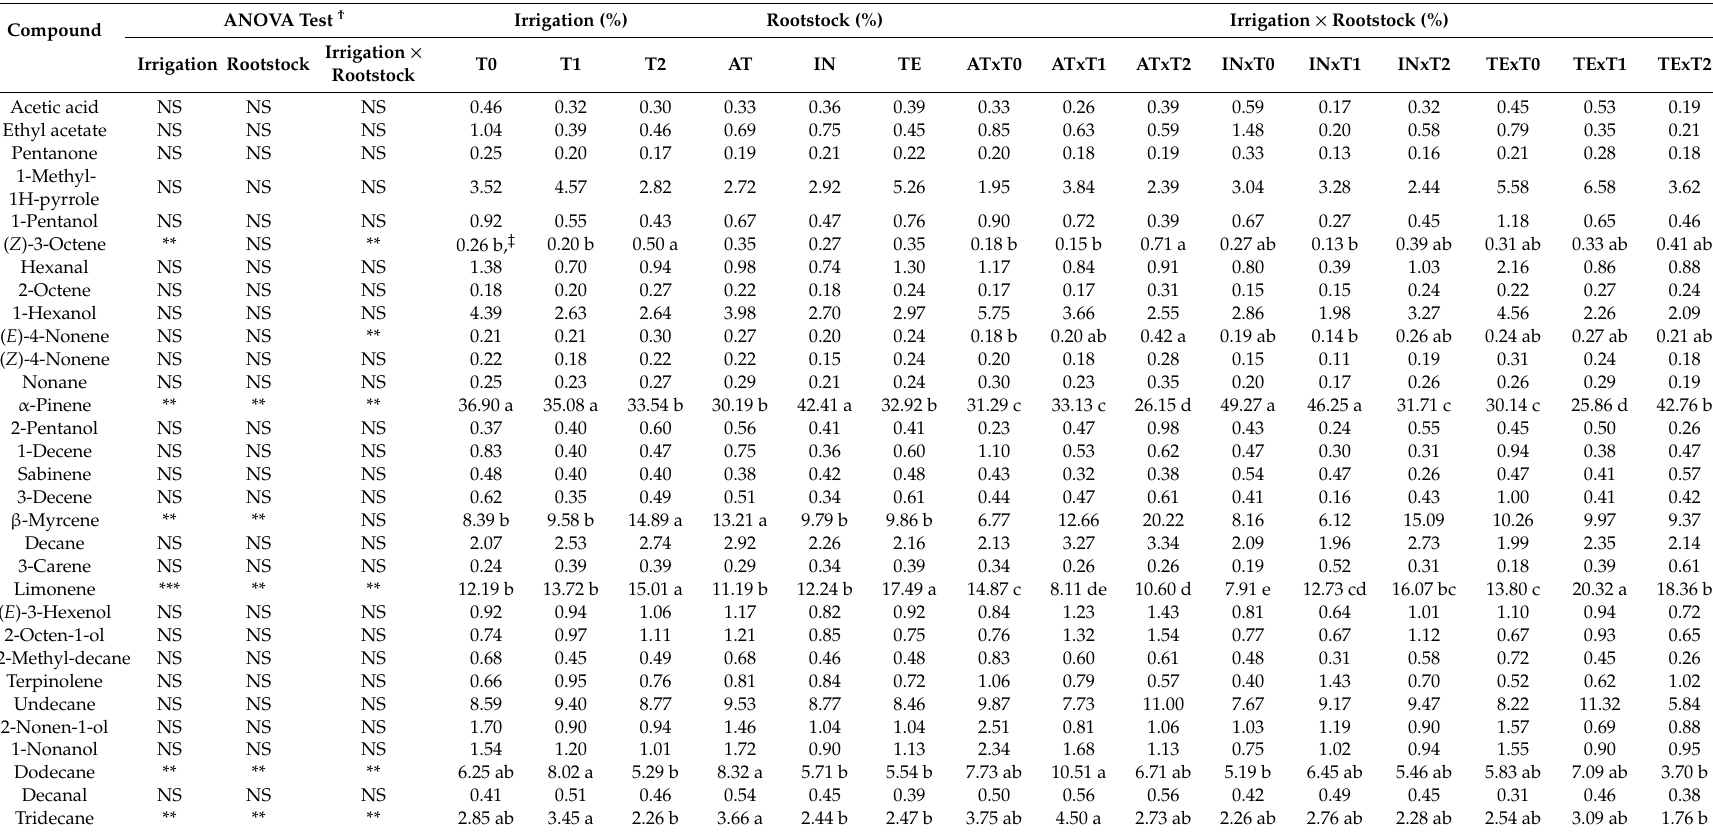
Table 1. Relative content (%) of volatile compounds on pistachios a ff ected by regulated deficit irrigation and rootstocks.